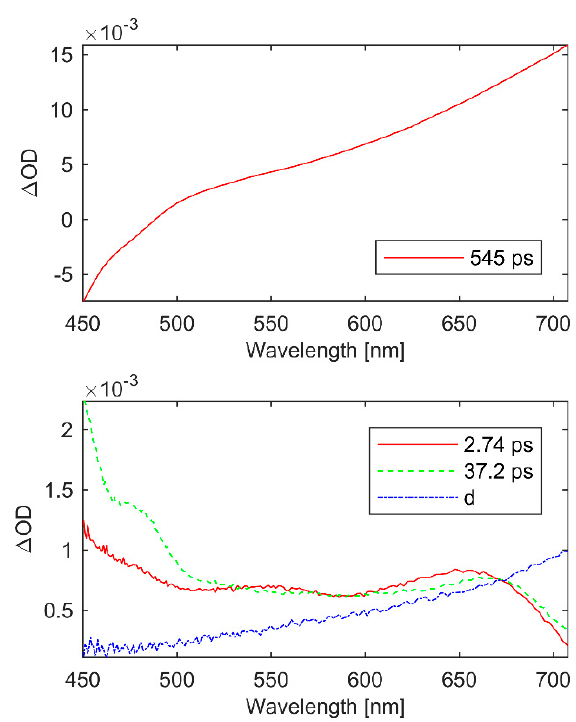
Figure 6. Spectral basis vectors for molecule “A”. See Equation (1) for explanation.